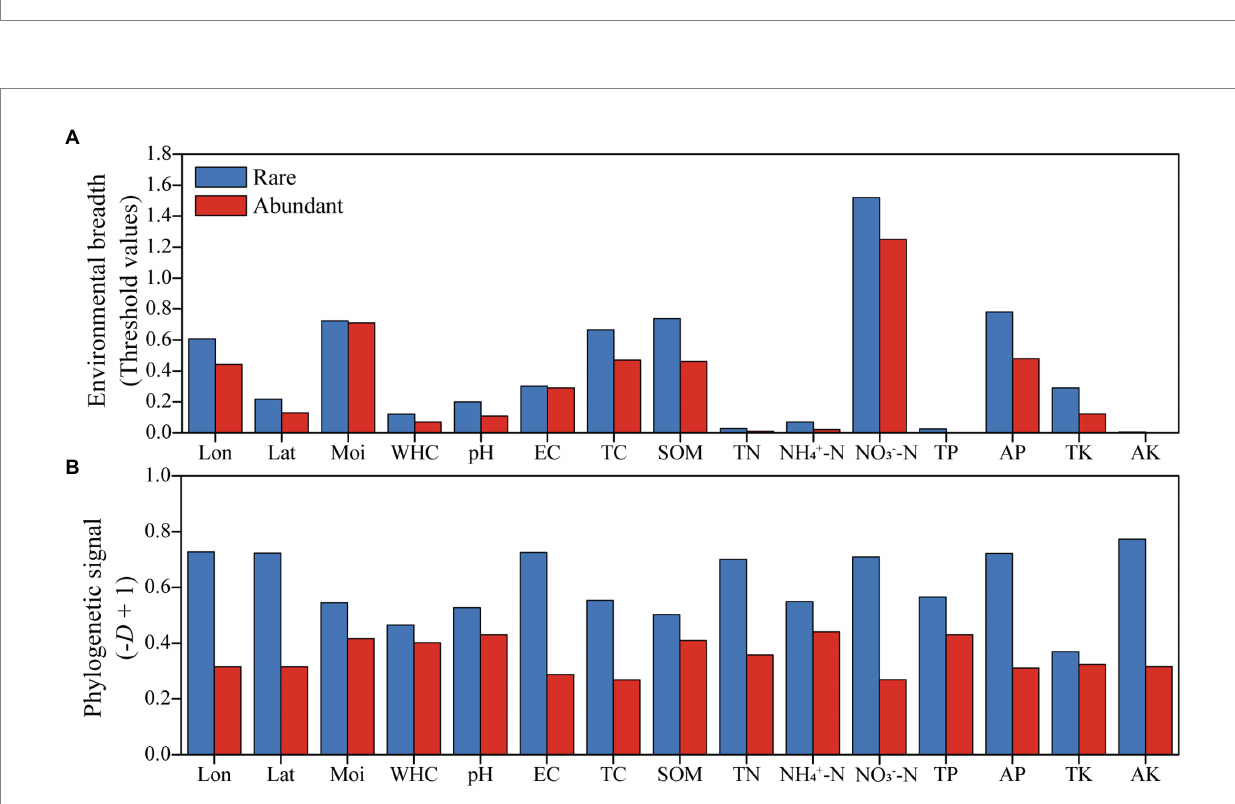
FIGURE 4 Environmental adaptability of abundant and rare bacteria in woodland soils. (A) Environmental breadths were assessed by the response thresholds of rare and abundant bacteria to environmental factors. (B) Phylogenetic signals reflect the conservation of environmental preference traits in rare and abundant taxa. Abbreviations for environmental variables were described in the “materials and methods”